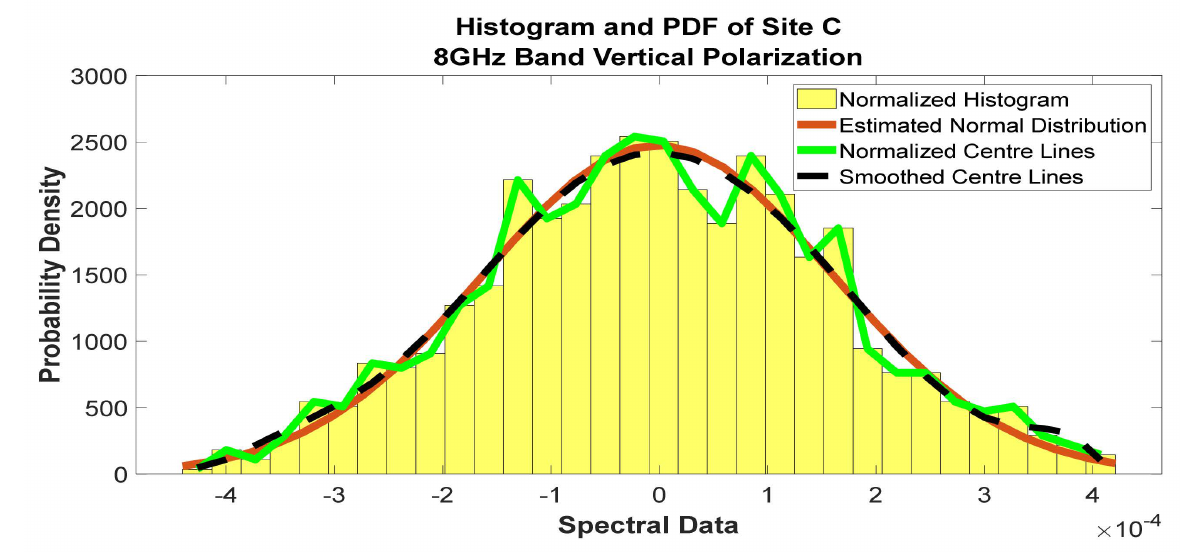
Figure 33. Histogram and PDF of the frequency scan for site C at 8 GHz vertical polarization.